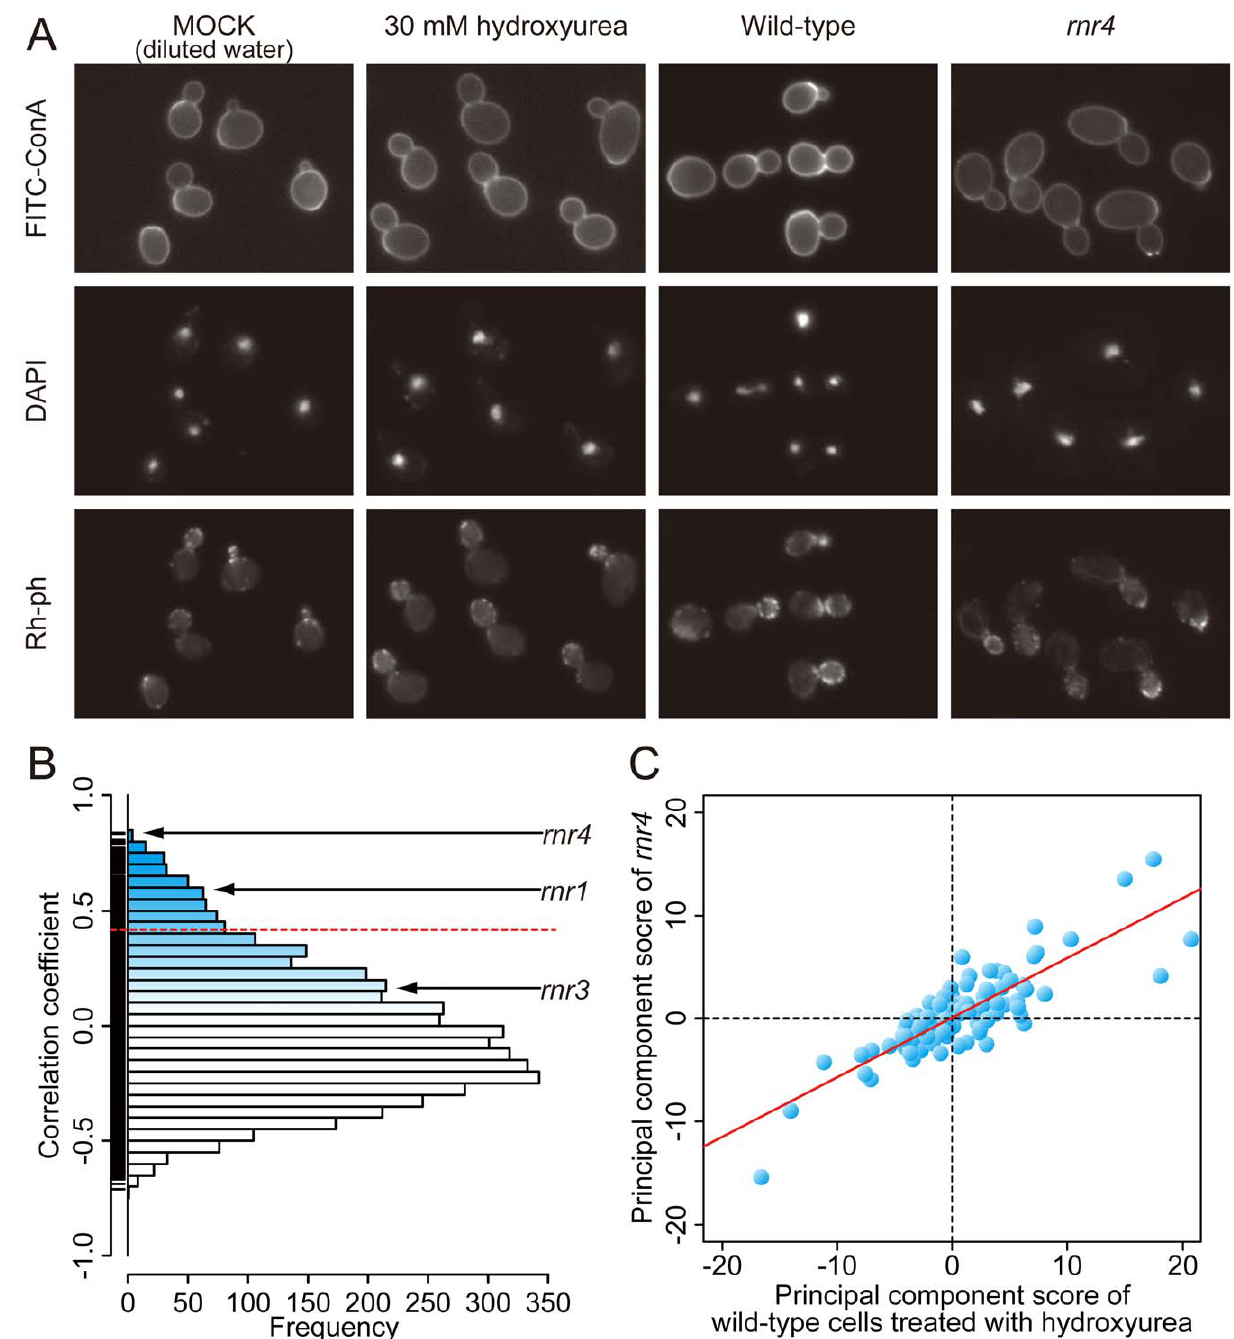
Figure 2. Hydroxyurea treatment and the results of target inference. A) Photographs of wild-type cells treated with 30 mM hydroxyurea and the rnr4 mutant. Cells were triply stained with FITC-ConA, Rh-ph, and DAPI. Quantitative analysis of the hydroxyurea-induced morphologic changes is summarized in Table S1. B) A histogram of correlation coefficients (R) between the mutant and hydroxyurea-treated wild-type cells. The dashed red line indicates the position of the R value corresponding to the two sided P value of 0.05 with the Bonferroni correction based on a correlation coefficient test. C) Two-dimensional plot of wild-type cells treated with hydroxyurea and the rnr4 mutant. The scores for the 104 principal components are plotted. The red line indicates a linear regression model (R =0.738). Echinocandin B Previous results [8] detect no more than two parameters from the hmg1 and hmg2 mutants with normal distributions on one side We used echinocandin B as representative of agents that at P , 0.0001, suggesting that our high-content image-profiling damage the cell wall. Echinocandin B, which is produced by method can detect mutants of genes with major cellular roles even Aspergillus nidulans and Aspergillus rugulosus [30], has an antifungal activity owing to an specific inhibition of the synthesis of 1, if the mutant show a weak phenotype.